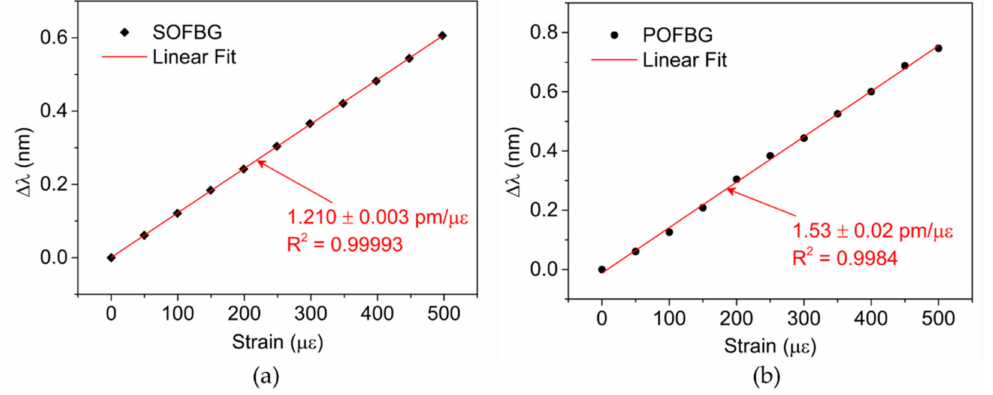
Figure 2. Wavelength response to strain: ( a ) SOFBG. ( b )